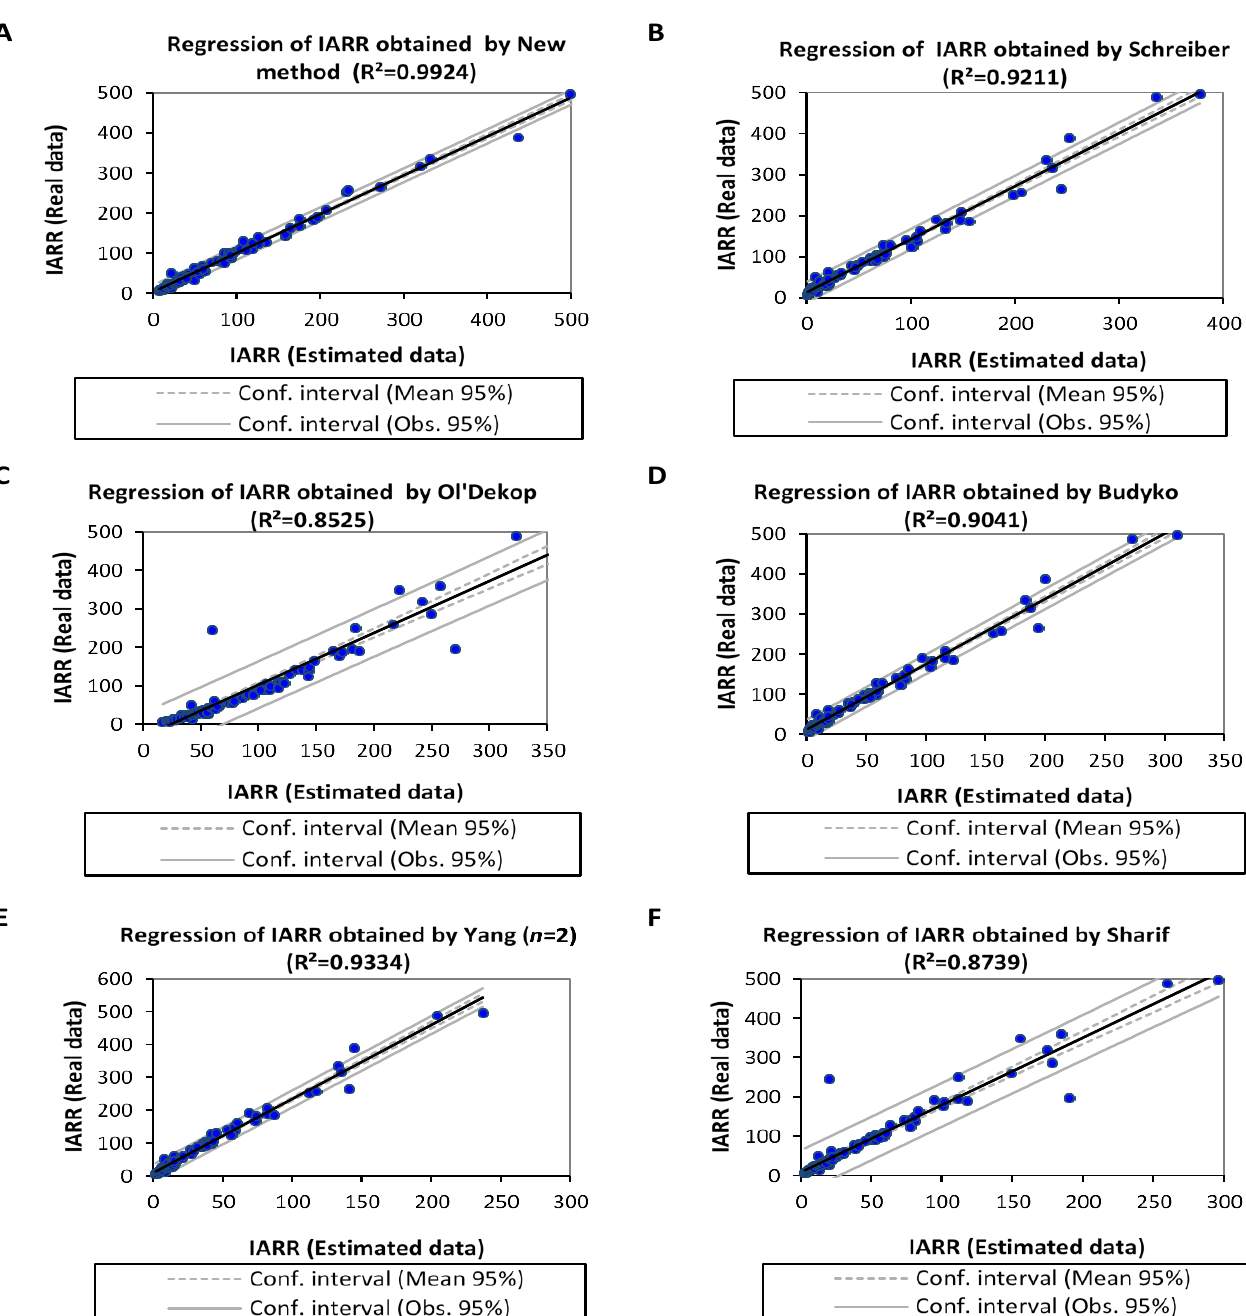
Figure 8. Linear regression graphs between real and estimated inter-annual rainfall-runoff obtained by applying new method ( A ), Schreiber ( B ), Ol ’ Dekop ( C ), Budyko ( D ), Yang ( E ), and Sharif ( F ) models. Coefficient of determination (R 2 ).